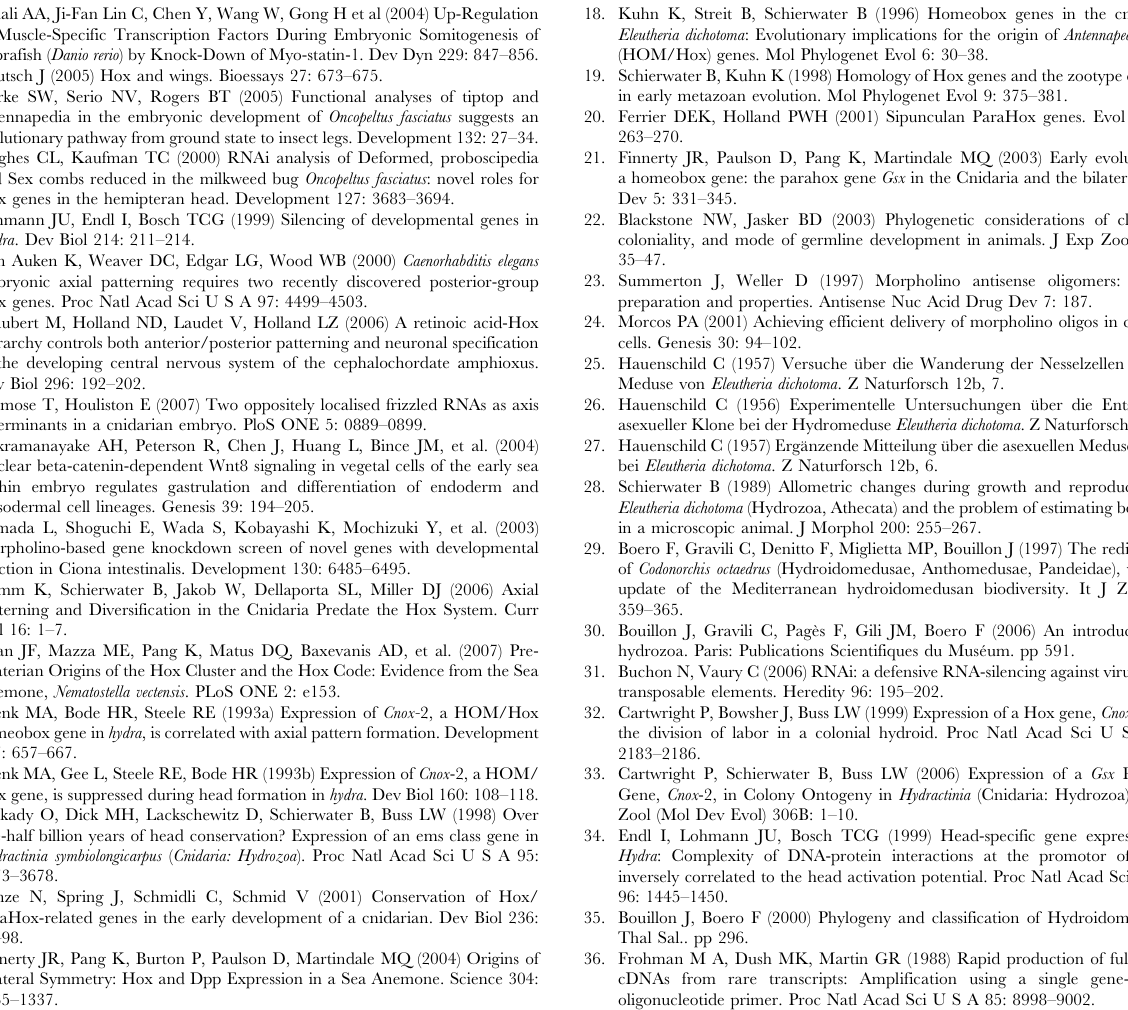
Figure S5 In vivo detection of fluorescein-labeled dsRNA (A) and morpholino oligomers (B) after transfection. Figure S6 Target gene in situ hybridization of knock down animals. In situ hybridization of Cnox -1 gene in a Cnox -1 knock down animal (A’), in a RNAi-control animal (B), in a Morpholino- control animal (B’) and Cnox -3 in situ hybridization in a Cnox -1 knock down animal. Medusa morphology is shown in light microscopy (A) and DAPI staining of the same medusa (A’). Found at: doi:10.1371/journal.pone.0000694.s006 (0.29 MB